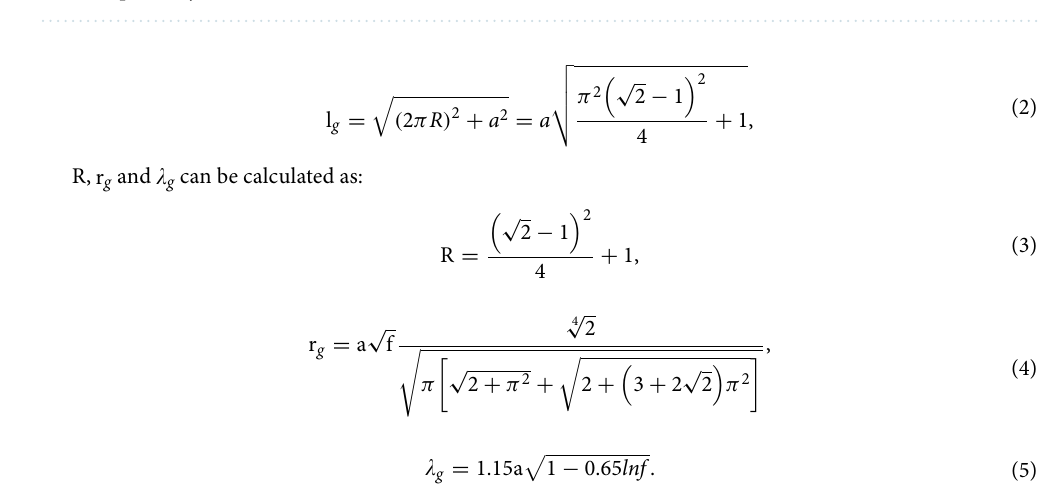
Figure 1. (A) The schematic structure of the gyroidal graphene PSi-PC, (B) gyroidal model 37 , (C) unit cell of tri-helical gyroid 20 , and (D) helix geometrical sizes 20 . For (B–D) (reprinted/adapted) with permission from ref. 37 and 20